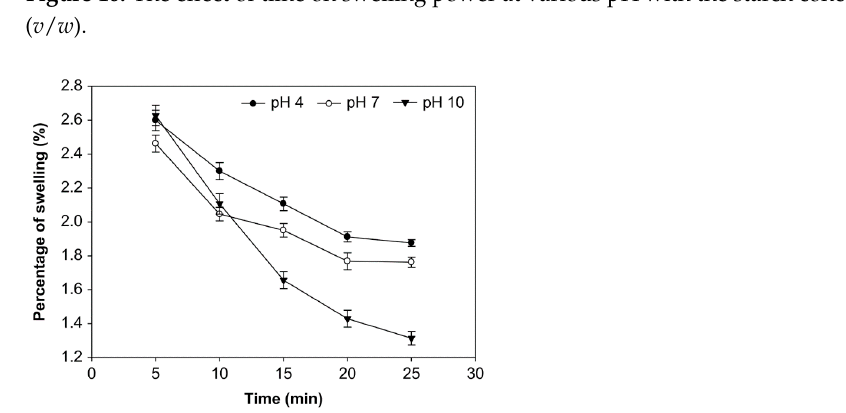
Figure 11. The effect of time on swelling power at various pH with the starch concentration of 20% ( v / w ).